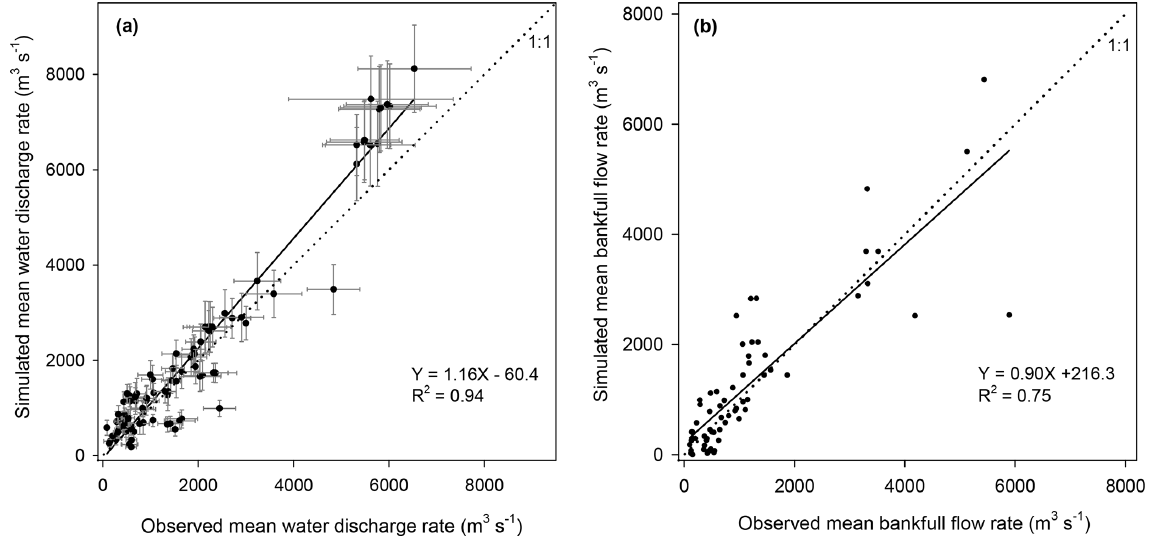
Figure 3. Comparison between observed and simulated riverine water discharge rates (a) and bankfull flow rates (b) . In panel (a) , the error bar denotes the standard deviation of interannual variation. Sources of the observed riverine water discharge rate and bankfull flow rate can be found in Table 1.